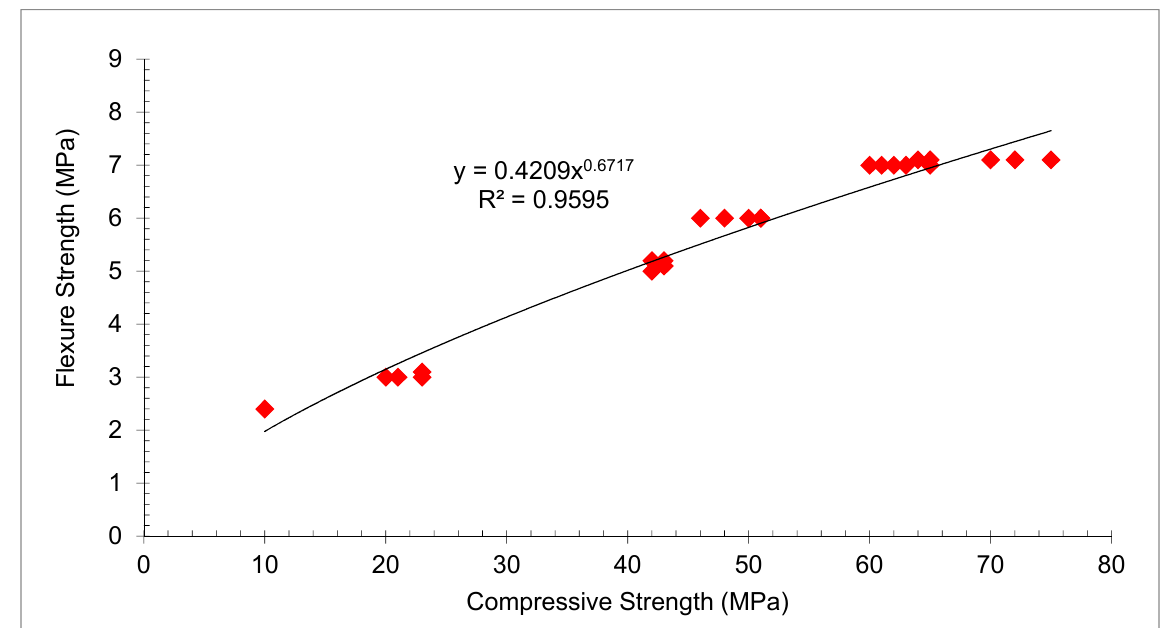
Figure 9. The correlation between CS and FL: Data source [65].